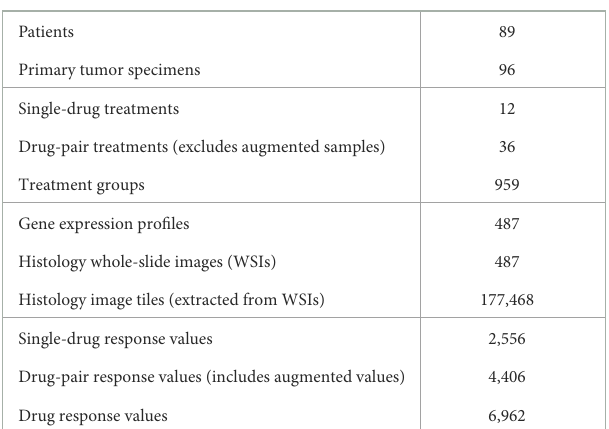
TABLE 1 Summary of the PDX drug response dataset used for building prediction